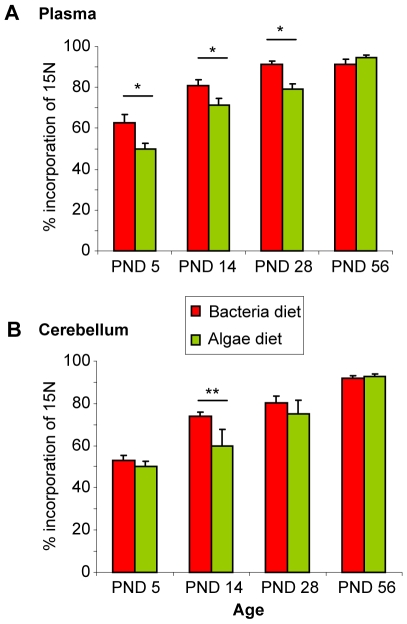
Incorporation rate of 15N in (A) plasma and (B) brain proteins.In 5, 14 and 28 day old animals (PND 5, 14, 28) bacteria diet feeding provides a significantly higher incorporation of 15N in plasma proteins compared to blue-green algae diet; only at the age of 56 days, blue-green algae fed diet animals show the same 15N incorporation. In the cerebellum, a faster incorporation in adolescence at PND 14 reached significance (**p<0.01; *p<0.05).